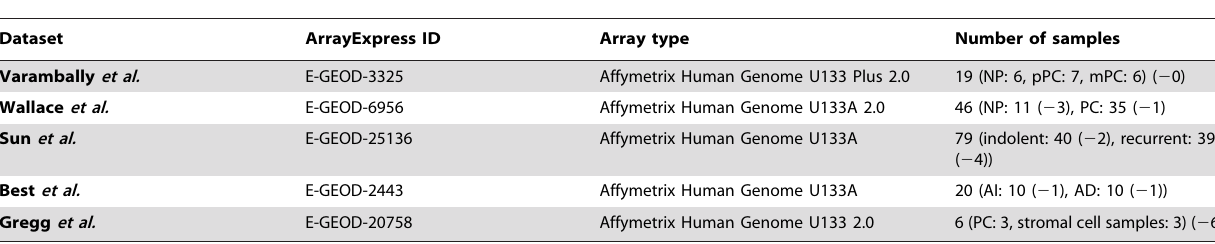
Table 1. Characteristics of the selected